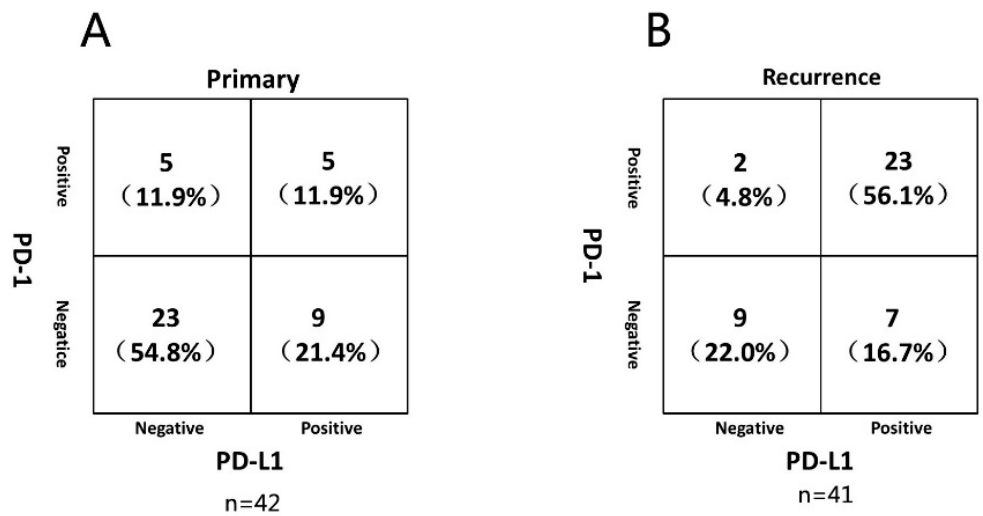
Figure 5. Correlation between PD-1 and PD-L1 in primary ( A ) and recurrent ( B ) gliomas. Table 3 compared baseline data of the PD-1 -negative and PD-1 -positive group. Table 4